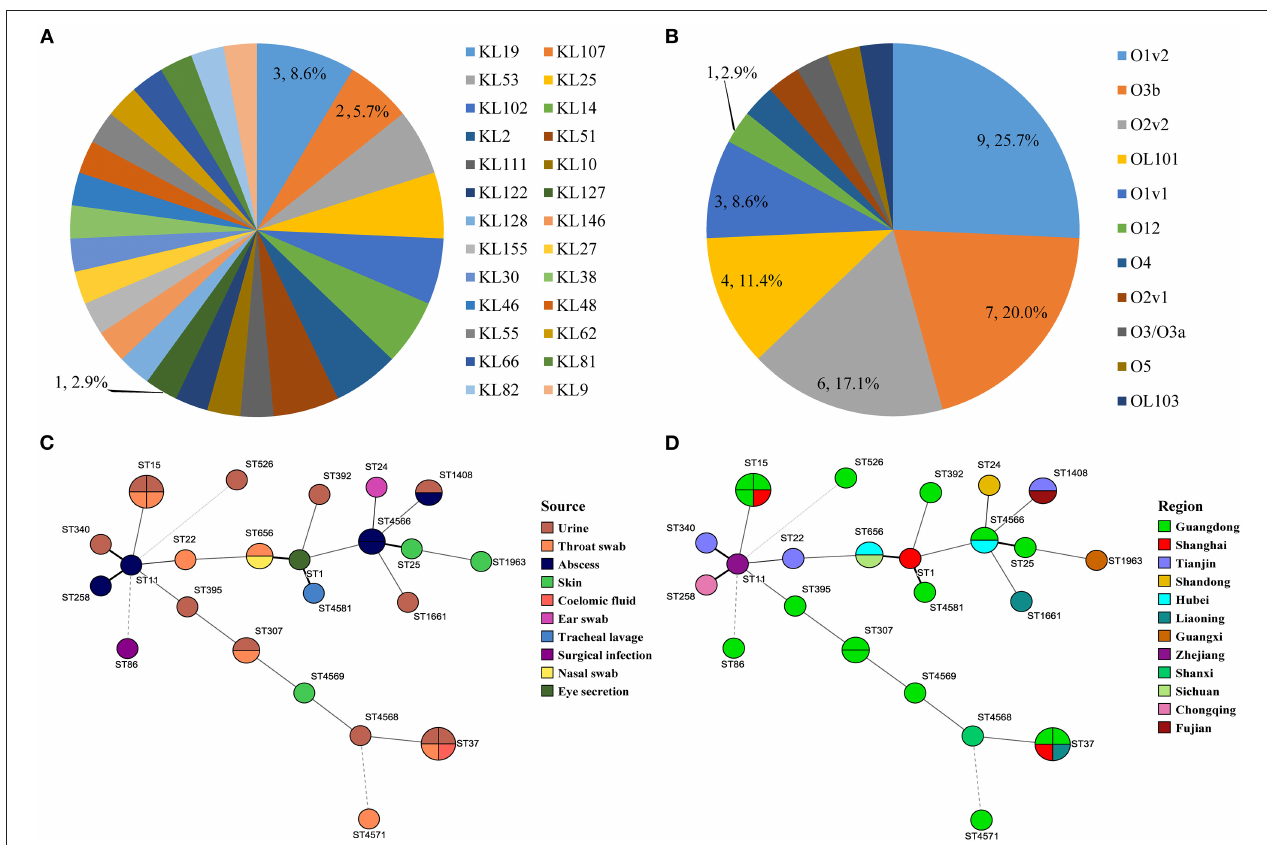
FIGURE 3 | Serotype distribution of capsular serotype and O antigen (A,B) . Minimum spanning trees of MLST data (except K. variicola ) based on source and region (C,D) .